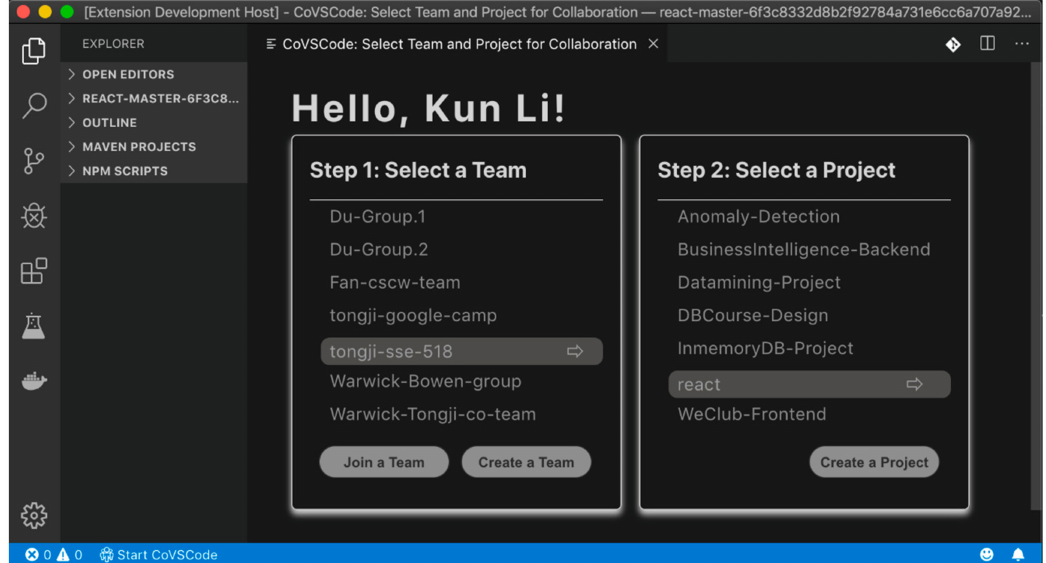
Figure 7. UI snapshot of the CoVSCode client’s initialization